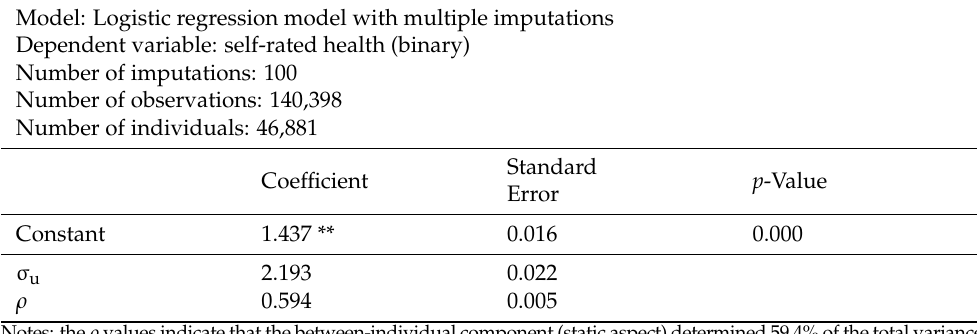
Table 2. Results of the null